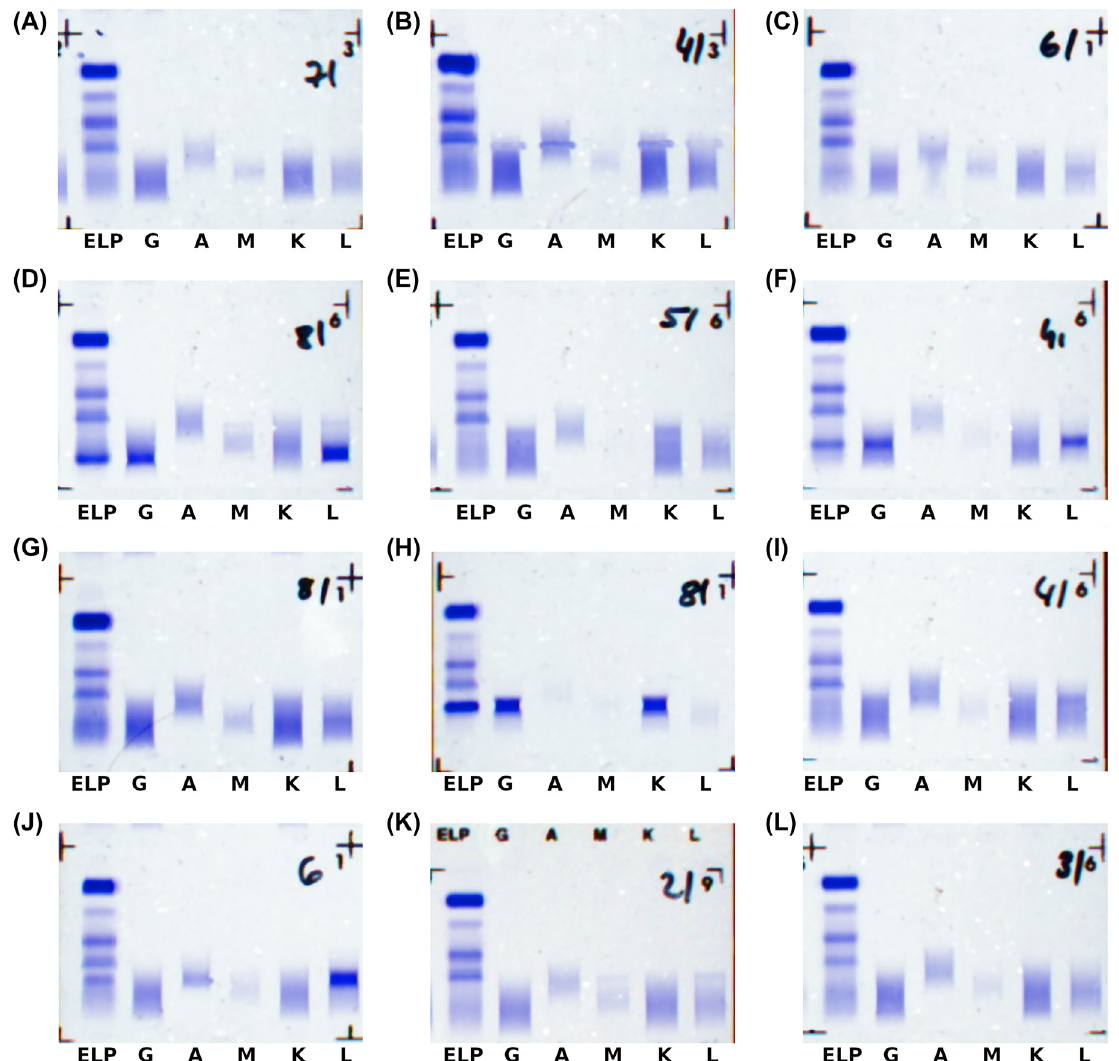
Figure 3: Examples where AI assessment and expert label deviate. (A) Negative (assessment) instead of IgM-Kappa (label); (B) free chain (assessment) instead of IgG-Lambda (label), note the artefacts in the image; (C-E) bi-/oligoclonal (assessment) instead of the labels IgG-Lambda (C), IgG-Lambda (D), and IgG-Kappa (E); (F) IgG-Lambda (assessment) instead of IgG-Lambda + Lambda (label); (G) IgG-Lambda (assessment) instead of IgG-Kappa + Lambda (label); (H) IgG-Kappa (assessment) instead of biclonal IgG-Kappa (label); (I) IgG-Lambda (assessment) instead of single-lambda (label); (J) IgA-Lambda (assessment) instead of single-lambda (label); (K) IgG-Lambda (assessment) instead of inconclusive (label); (L) IgG-Kappa (assessment) instead of inconclusive